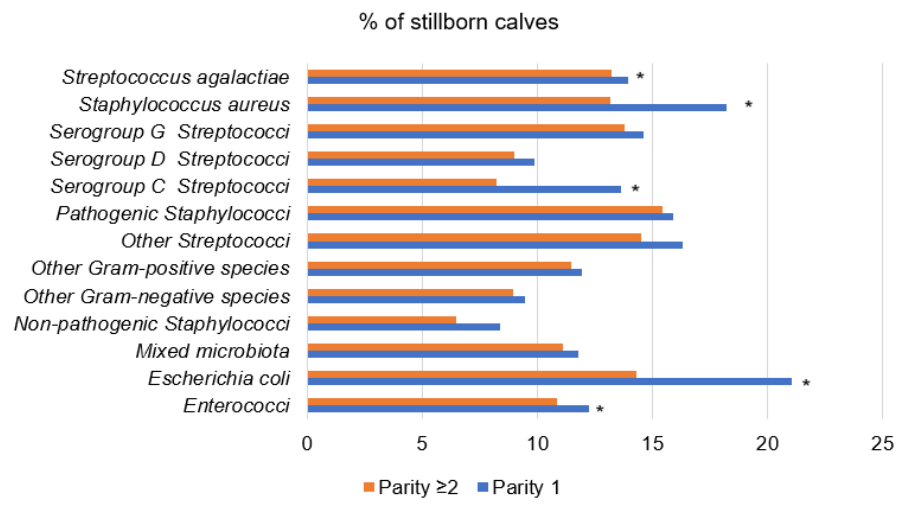
Figure 3. Percentage of stillborn calves by group of cows according to mastitis agent and parity. *– the difference between the frequencies of the parities groups is statistically significant ( p < 0.05).